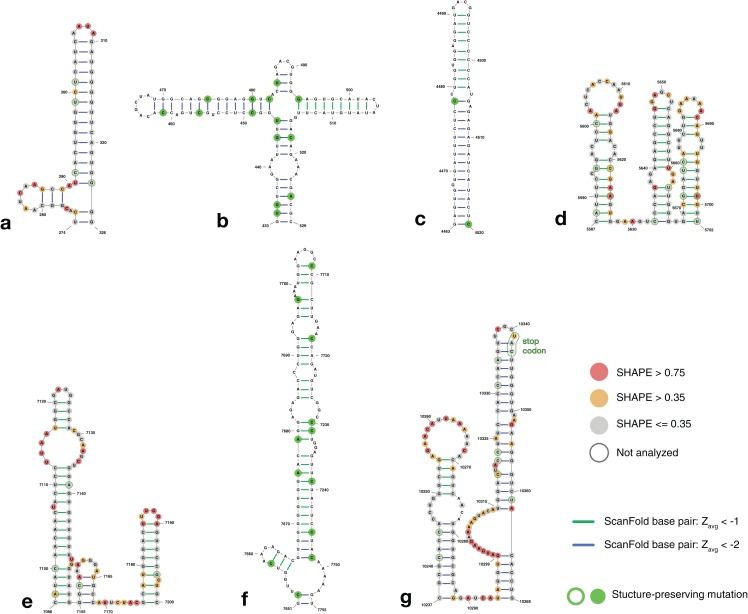
Structure models of ZIKV coding region motifs which contain ScanFold-Fold base pair hits with Zavg < −2. Structures are shown in the order they appear throughout the ZIKV genome (KJ776791.2).(A) and (B) depict the structural models of the ScanFold-Fold predicted motifs adjacent to the previously annotated 5′ structured region, located from nt 274–326 and 433–529, respectively. (C–F) are structures that appear within the core coding region located from nt 4,463–4,520, 5,587–5,702, 7,096–7,205, and 7,651–7,755, respectively. Structure (G) is directly upstream of the 3′ structured region, located at nt 10,237–10,368, and has been annotated to show the location of the stop codon near the terminal loop (circled in green). Base pairs are colored by their z-score cutoff; green lines show base pairs which were predicted in the z-score < −1 results (Fig. S1D; Table S4) and blue lines show base pairs which were predicted in z-score < −2 results (Fig. S1E; Table S5). Sites with structure-preserving mutations are highlighted with green circles. All nucleotides are shown with their SHAPE reactivity scores as shown in Huber et al. (2018).